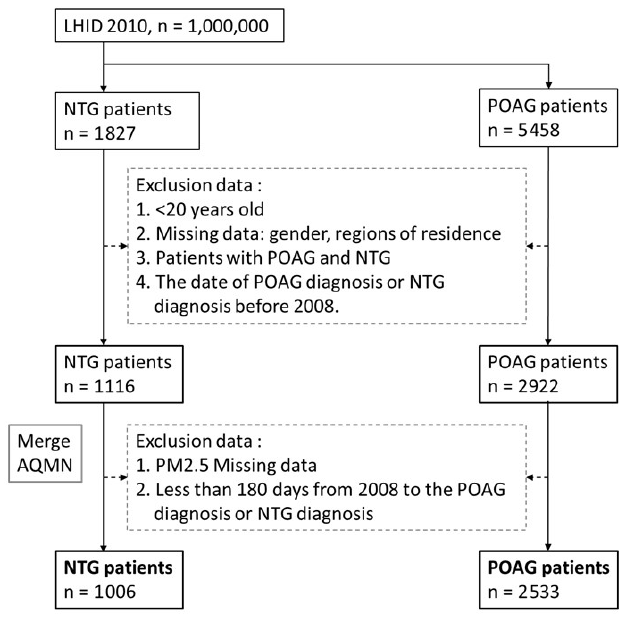
Figure 1. Flowchart of NTG and